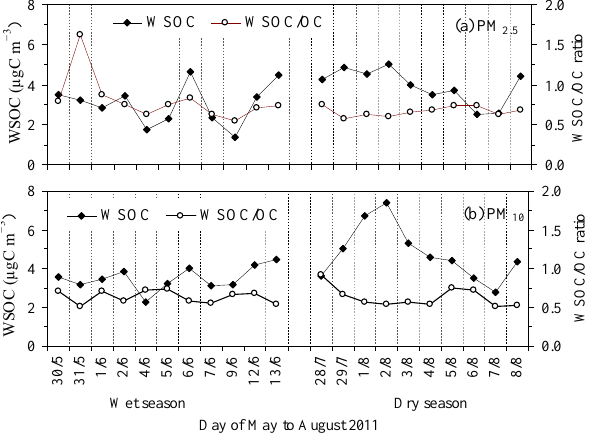
Fig. 5. Temporal variations of concentrations of WSOC and WSOC/OC ratios at Morogoro during the wet and dry seasons for PM 2 . 5 and PM 10 .